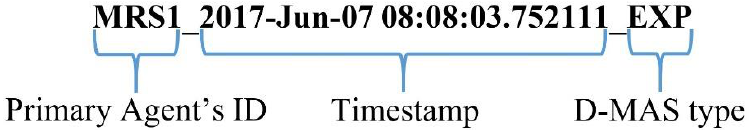
Figure 7. Ant colony ID.